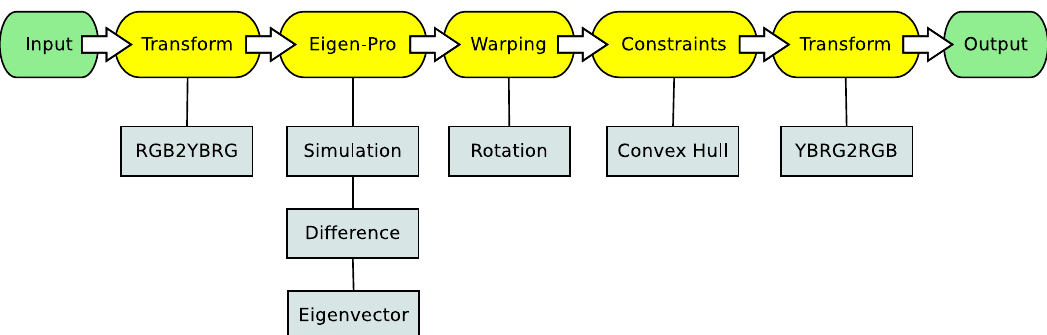
Figure 2. The flowchart of the proposed technique. In the pipeline, the images are first transformed to the λ , Y-B , R-G color space for the re-color processing, followed by a transformation back to the original RGB color